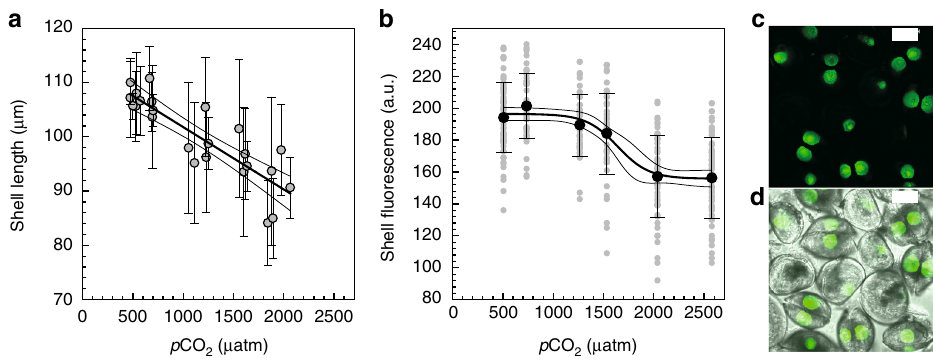
Fig. 5 Impact of CO 2 -driven seawater acidi fi cation on calci fi cation in PD I larvae from Exp 3 and 4. a Shell length at PD I, veliger larval stage. Data are means ± s.d. from N = 5 fertilizations and 10 – 25 animals per treatment and fertilization. Linear regression: shell length ( µ m) = 113.3 – 0.0115 p CO 2 ( µ atm), R 2